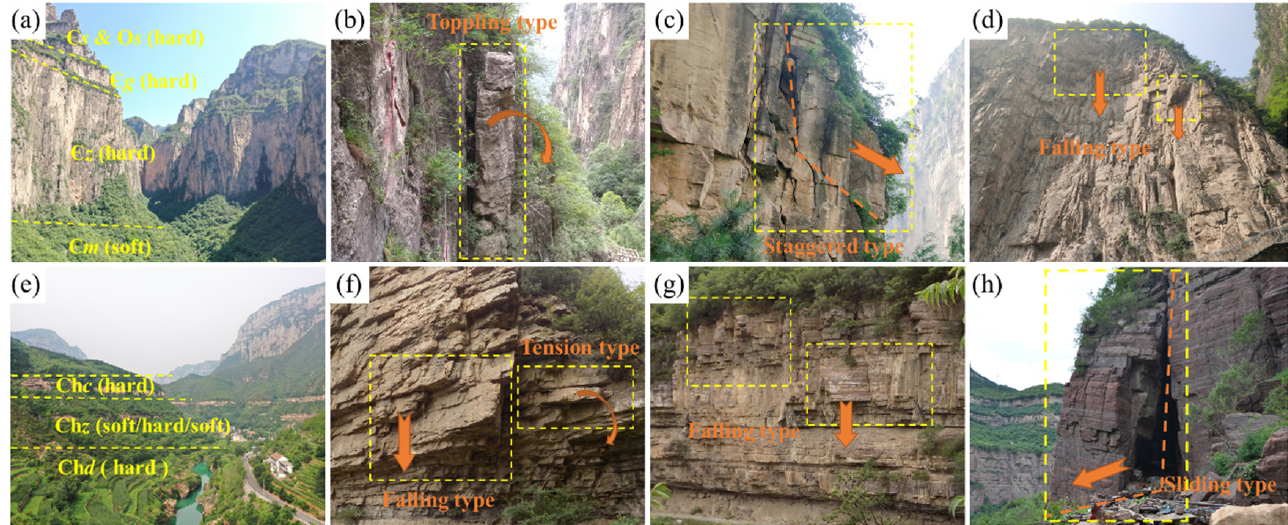
Figure 5. Correlation between stratigraphic structure characteristics and rockfall development pattern in the study area. ( a – d ) Failure modes of rockfalls in the upper hard and lower soft strata. ( e – h ) Failure modes of rockfalls in the soft-hard alternating strata.